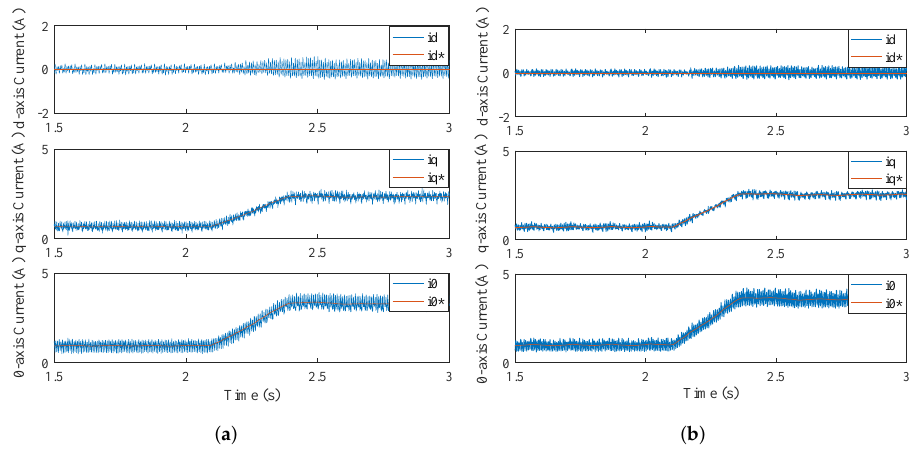
Figure 8. Experimental results of the dq 0-axes currents with the load torque change. ( a ) Method in [14]. ( b ) 2 DOF IMC ADO method.